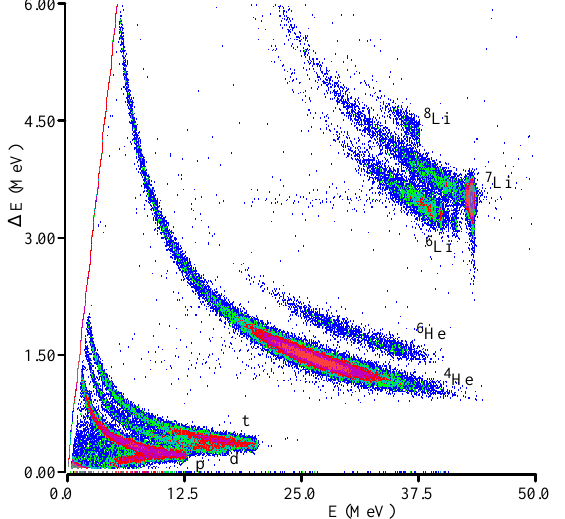
Fig. 4. (color on line) Particle identification plot of energy loss vs total energy obtained in the telescope placed at θ lab = 50 ◦ for beam energy of 45 MeV. The di ff erent reaction products are la- beled.